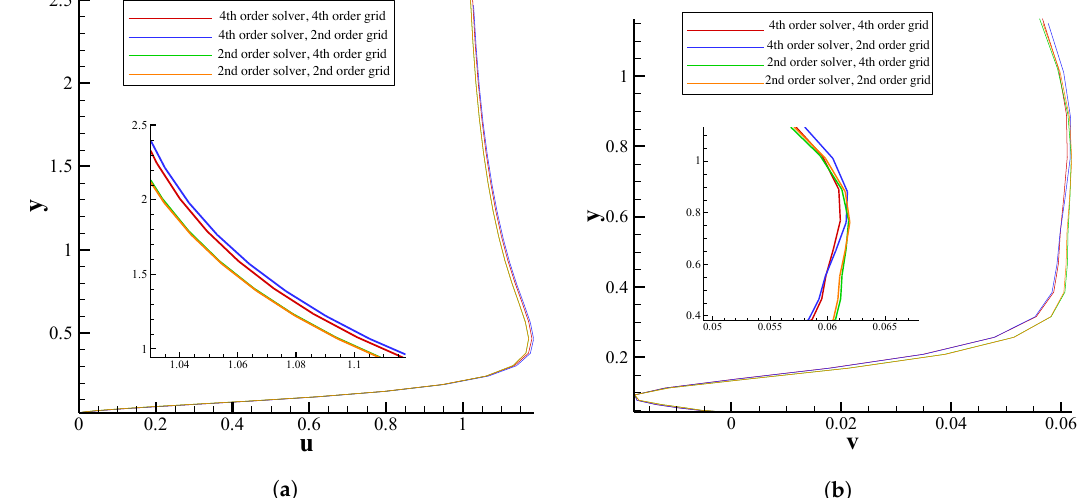
Figure 14. Comparison of the ( a ) horizontal and ( b ) vertical velocity components obtained using second- and fourth-order flow solvers with different generated grids for flow around a NACA 0012 airfoil with Ma = 0.85 and Re =